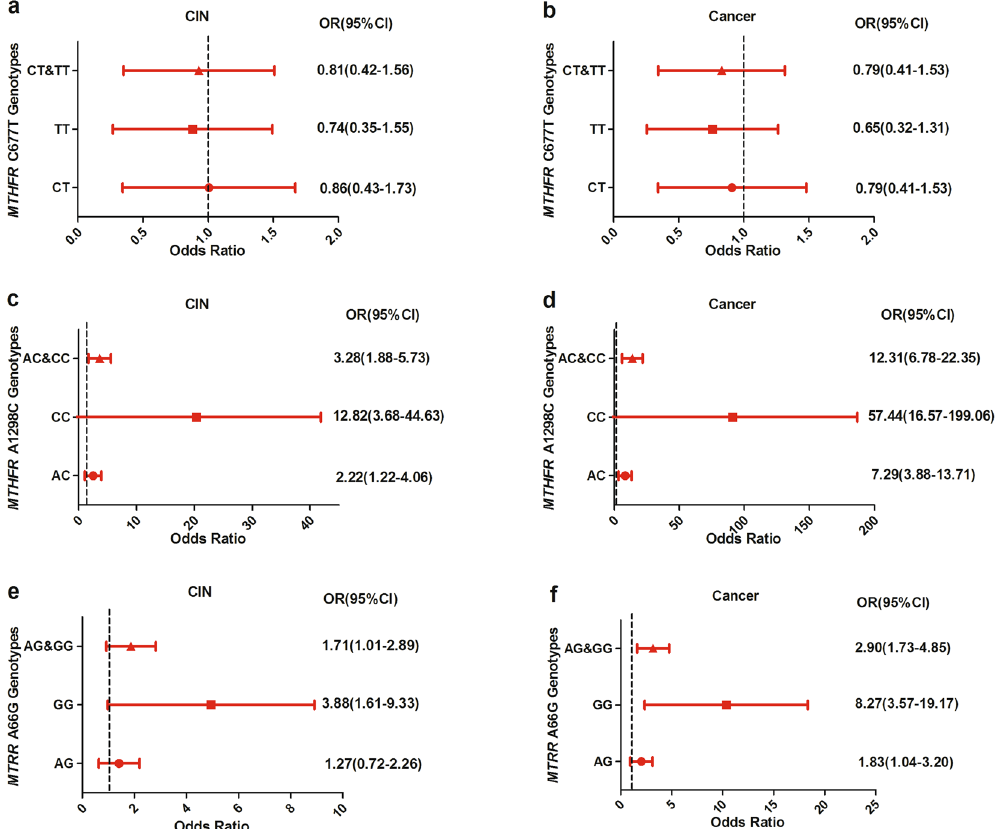
Figure 3. Association of MTHFR and MTRR polymorphisms with risk of cervical cancer. ( a ) MTHFR C677T genotypes associated with CIN, ( b ) MTHFR C677T genotypes associated with cervical cancer, ( c ) MTHFR A1298C genotypes associated with CIN, ( d ) MTHFR A1298C genotypes associated with cervical cancer, ( e ) MTRR A66G genotypes associated with CIN, ( f ) MTRR A66G genotypes associated with cervical